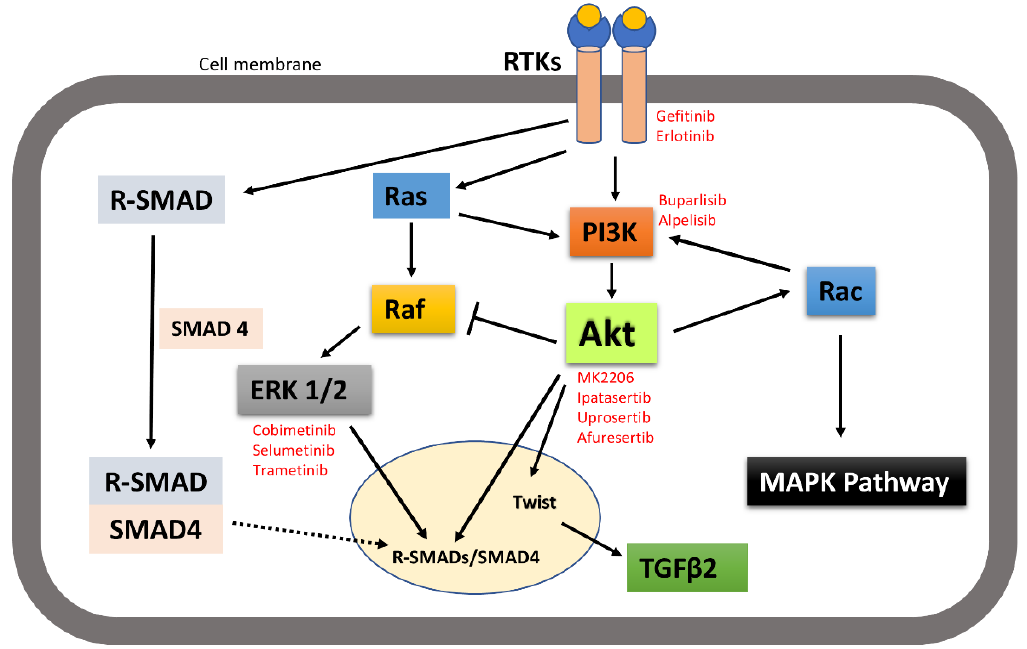
Figure 8. A simplistic graphical representation of the crosstalk between PI3K-Akt and RTK-activated other pathways. PI3K-Akt can crosstalk with MAPK and SMAD pathways to regulate their activities; thus, control cellular function. Solid arrow indicates activation, block arrow indicates inhibition, and dashed arrow indicates cellular distribution. Red texts indicate the inhibitors of the corresponding signalling molecules and receptors that are in various phases of clinical trial in treating cancer.